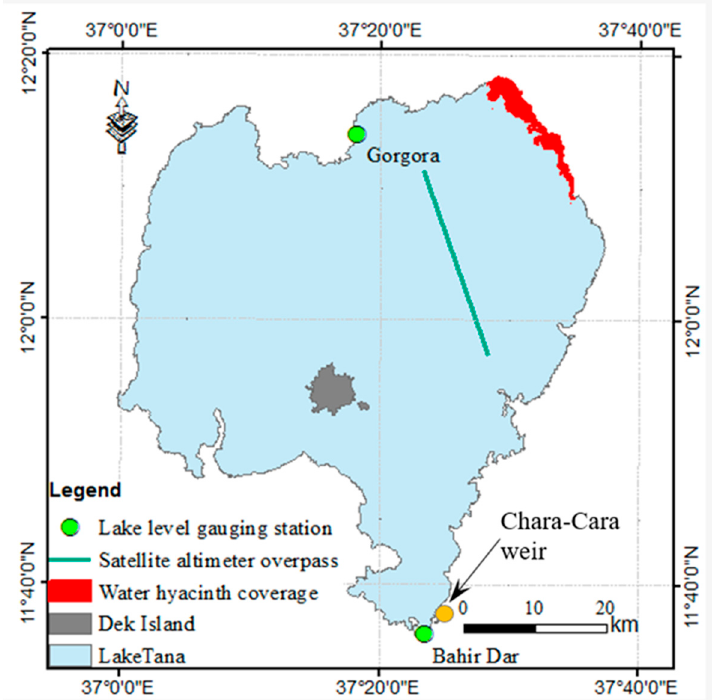
Figure 4. Ground lake level observation stations of Lake Tana, location of Chara-Chara weir, and footprint of Jason-1 and Jason-2 altimeter overpass over Lake Tana.